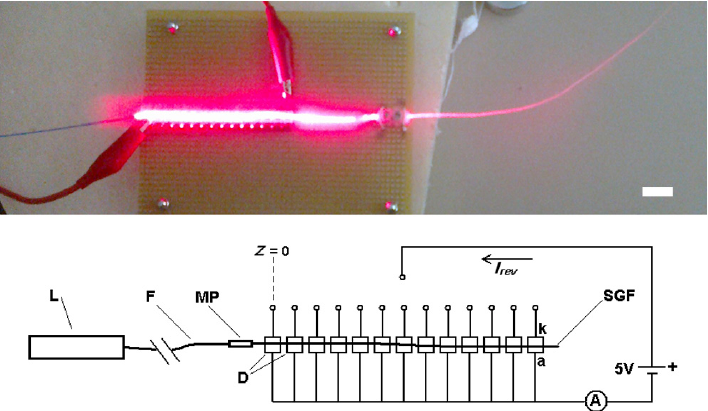
Figure 8. Experimental set-up for irradiance measurements: L, laser; F, optic glass fiber; MP, metal pipe; D, photodiodes; SGF, silkworm gut fiber; A, amperemeter; a, diode anode; and k, diode cathode. (Scale bar is 20 mm).